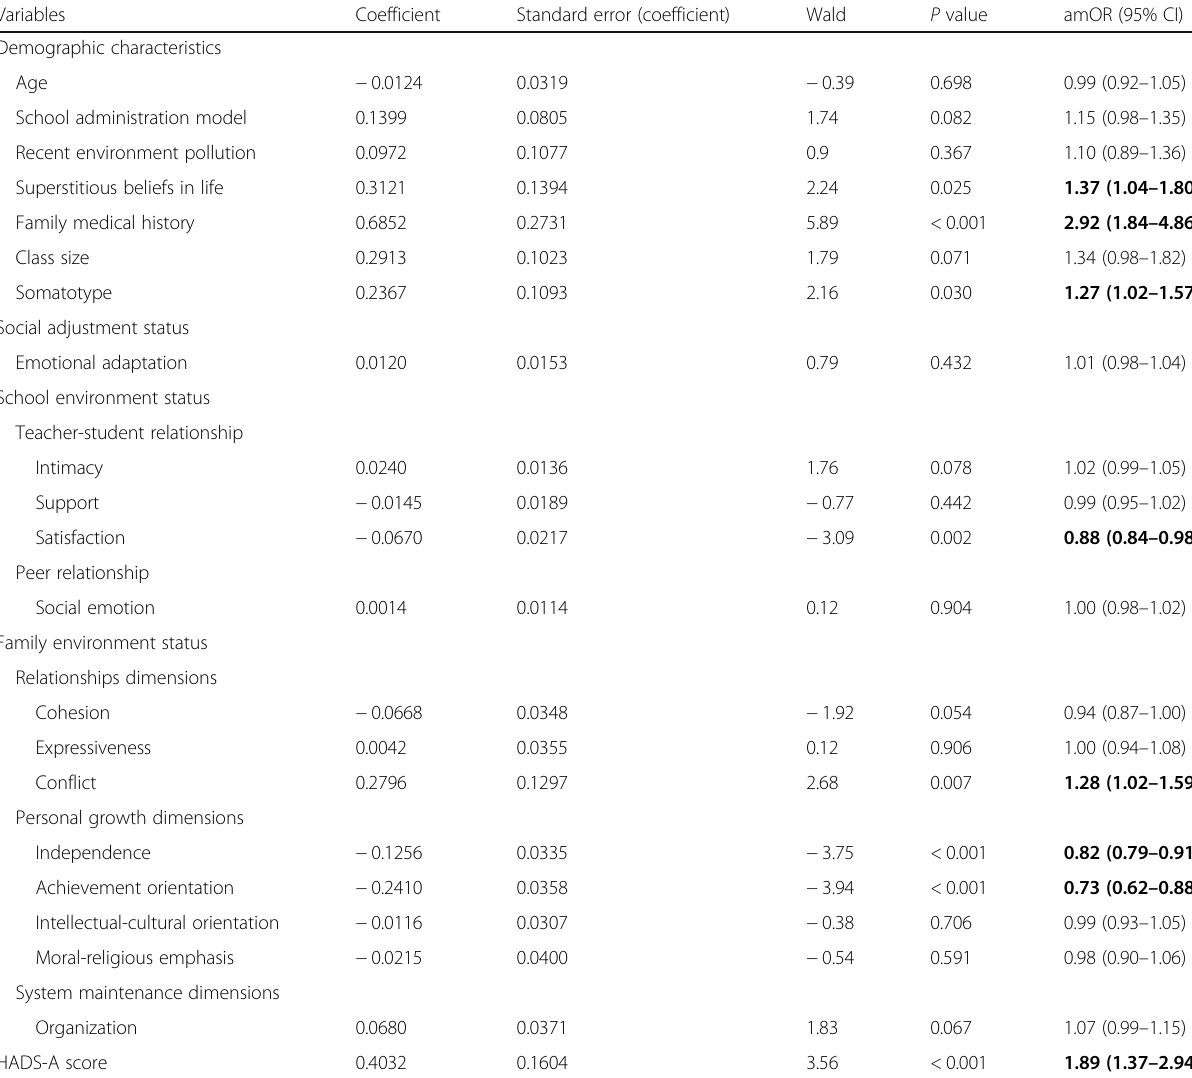
Table 4 Analyses of conditional multiple logistic regression of male HTs on HT-associated environment factors